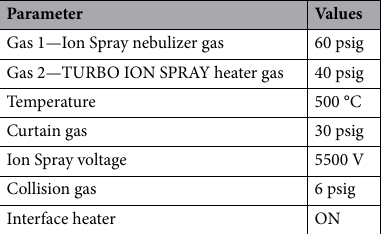
Table 3. Parameter optimization for electrospray ionization (ESI) probe.